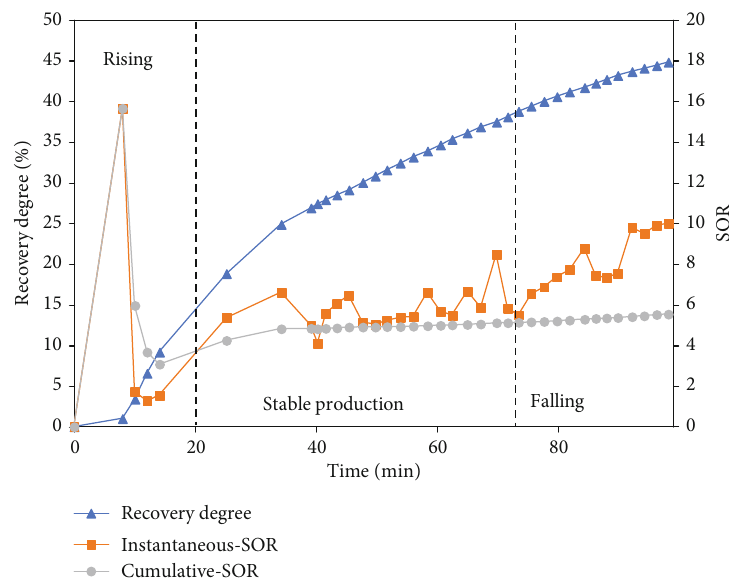
Figure 11: The recovery degree and SOR of 260 ° C superheated